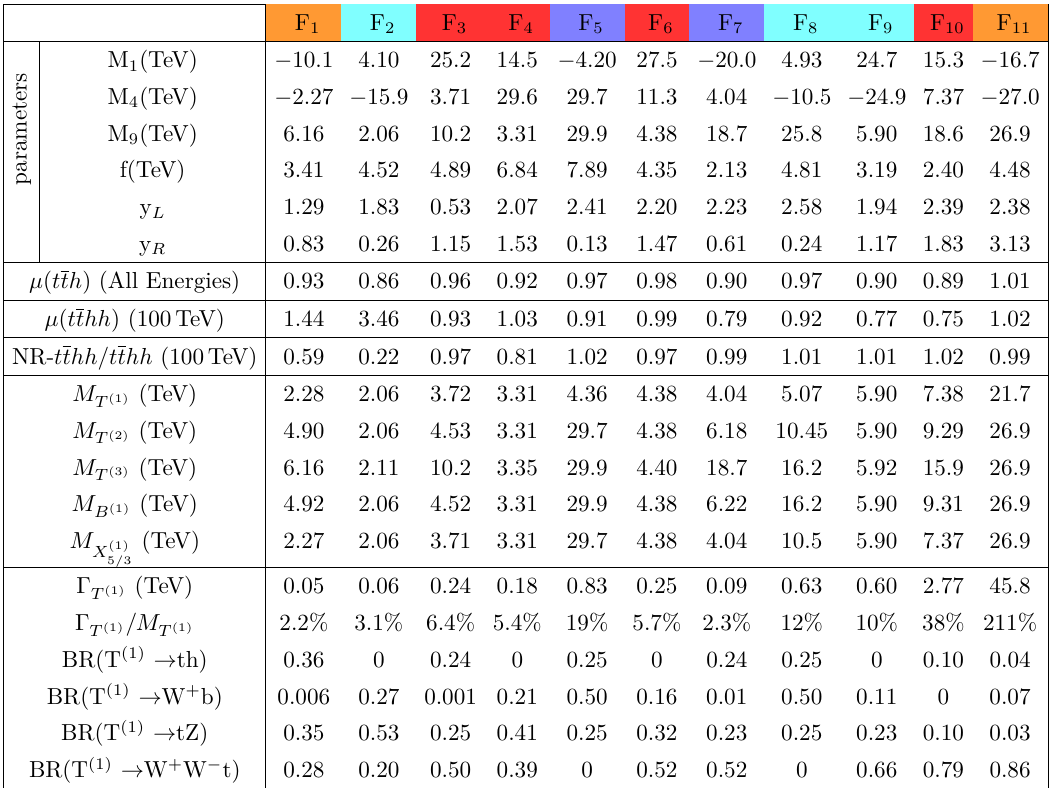
Table 8 . Benchmark points for the high scale MCHM 14 scan and their main features. Column headings indicate the region at which the point belongs, with red and orange meaning respectively Regions I and III (with same sign M 1 and M 4 ) and blue and cyan respectively for regions II and IV (with opposite sign M 1 and M 4